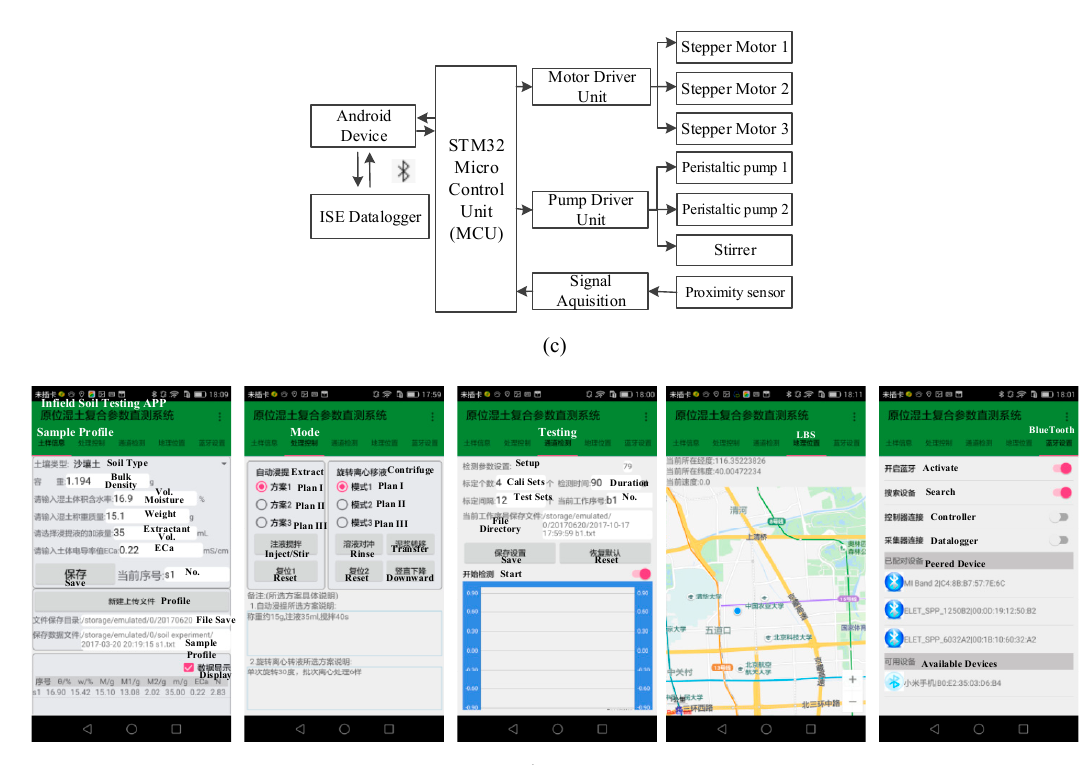
Figure 1. Diagram of the on ‐ site detection bench: ( a ) System Design A1, Stepper motor 1 A2. Proximity sensor 1 A3, Vertical slide table 1 A4, Peristaltic pump A5, Proximity sensor 2 A6, Injecting tube A7, Outlet tube A8, Blender A9, Soil sample container A10, Electronic weight scale B1, Stepper motor 2 B2, Proximity sensor 3 B3, Vertical slide table 2 B4, Proximity sensor 4 B5, Peristaltic pump2 B6, Rotary table B7, Stepping motor 3 B8, Pipe hanger B9,Centrifuge C1, Electrode hanger 1 C2, Electrode hanger 2 D1, Horizontal Lever meter D2, Positioner D3, Leveling screw E1, Circuit controller E2, ISE connector E3, Control switches and indicator lights E4, Control switches and indicator lights; ( b ) Physical